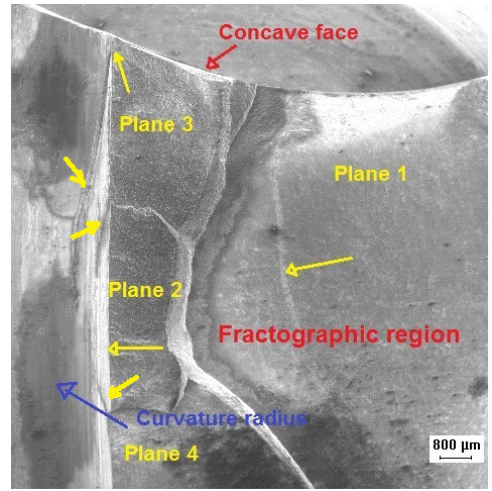
Figure 11. SEM images showing the fracture surface of the P2 blade.